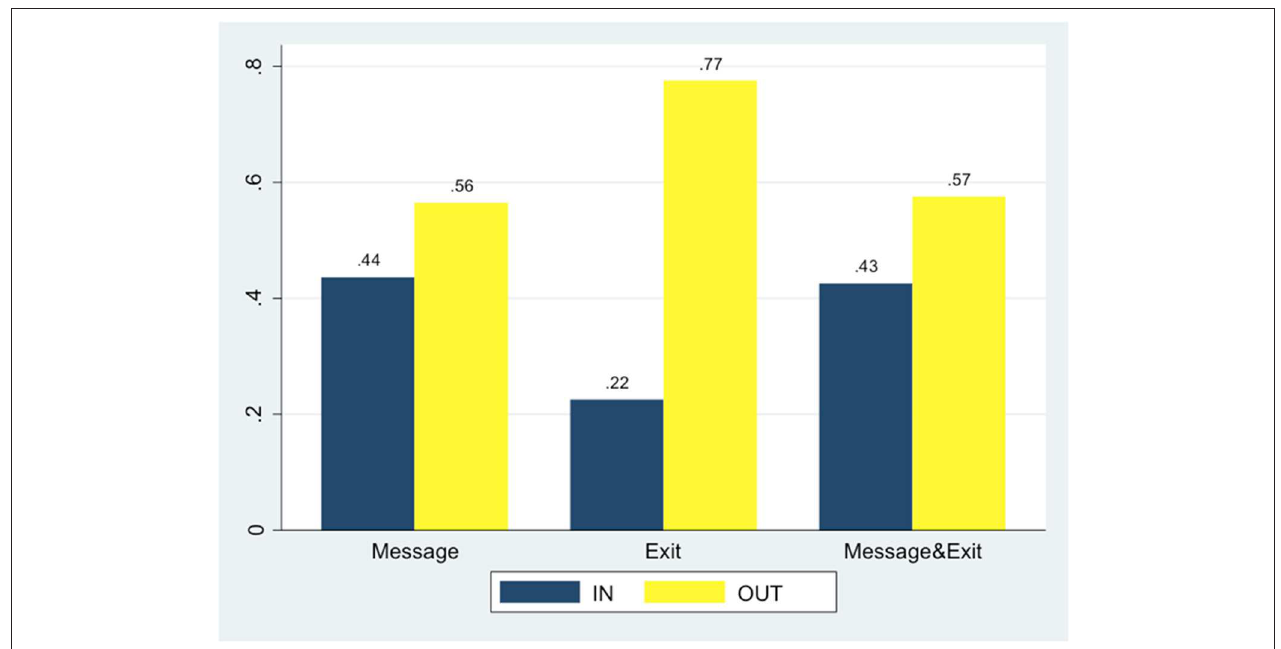
FIGURE 5 | As’ choices in different